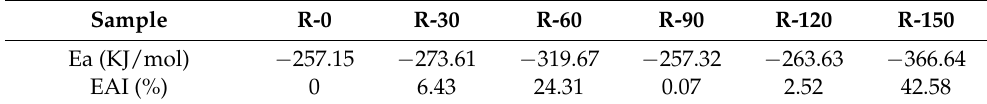
Table 7. Changes in flow activation energy before and after pitch